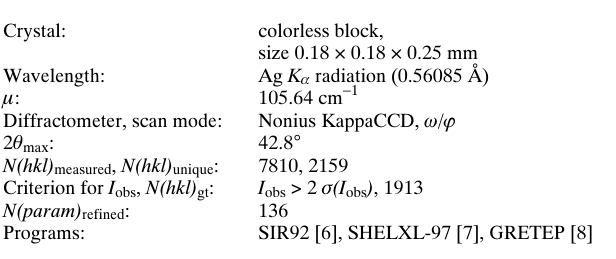
Table 1. Data collection and